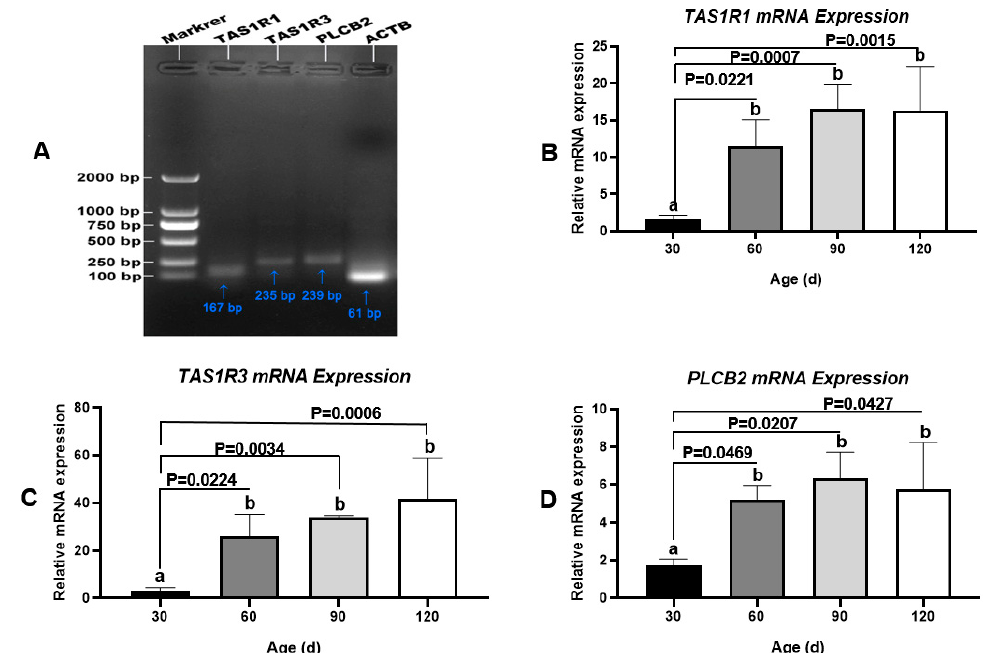
Figure 8. Transcription changes of umami tasting molecules, TAS1R1 , TAS1R3 and PLCB2 during testis development of the Congjiang Xiang pig, evidenced by q-PCR. Gel electrophoresis q-PCR result of TAS1R1 (167 bp), TA1SR3 (235 bp), and PLCB2 (239 bp), respectively. The mRNA levels of target genes were normalized with housekeeping gene ( ATCB, 61 bp) and expressed as 2 ‐ΔΔ CT using samples on day 30 as calibrator. Results are indicated by means ± SD (n = 3). Values not sharing the same letter (a, b) denote significant differences among groups ( p < 0.05).